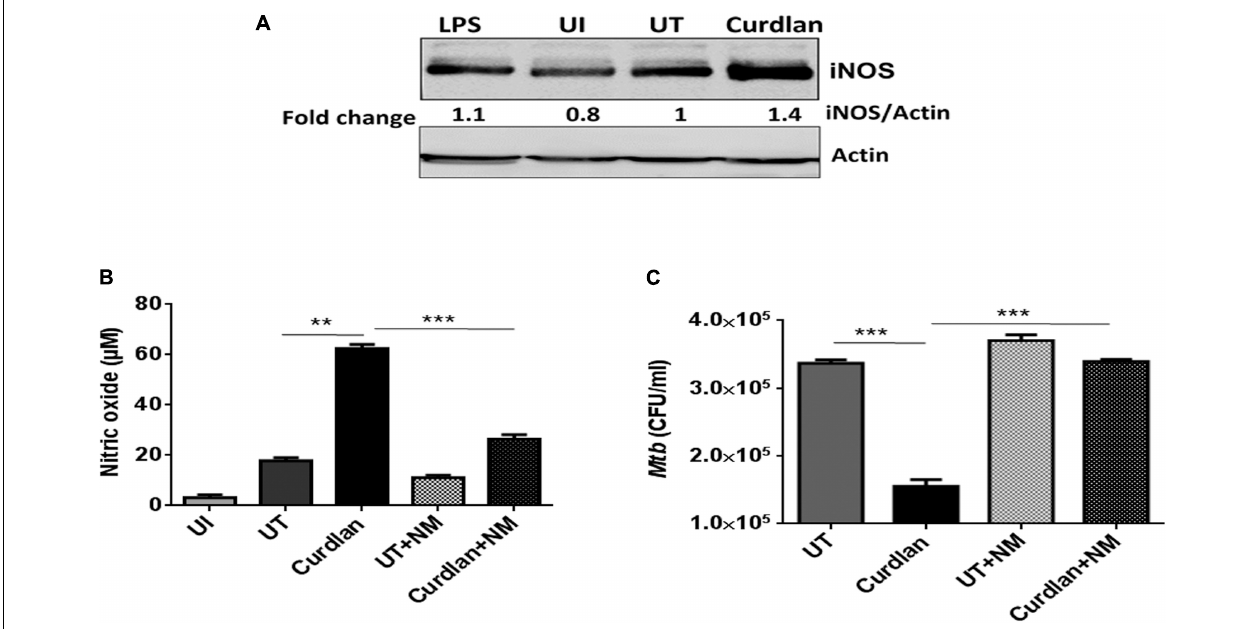
FIGURE 7 | Curdlan activated M (cid:56) s augments nitric oxide production. M (cid:56) s were infected with Mtb (MOI = 5) for 4 h, (A) cells were then stimulated with curdlan (50 µ g/ml) and after 18 h, iNOS protein level was assessed in cell lysates through western blotting; (B,C) Infected cells were pretreated for 1 h with iNOS inhibitor ( N -monomethyl-L-arginine; 20 µ M) prior to stimulation with curdlan for 48 h. Thereafter, (B) secretion of NO was monitored in cell culture SNs by Griess method; further, (C) cells were lysed and plated on 7H11 agar plates to determine Mtb survival by CFU assay. UI, M (cid:56) s not infected with Mtb ; UT, Mtb infected M (cid:56) s; Curdlan, Mtb infected and curdlan stimulated M (cid:56) s; NM, N -monomethyl-L-arginine. The data shown as the mean ± SD are representative from two independent experiments. ∗∗ p < 0.01, ∗∗∗ p < 0.001.